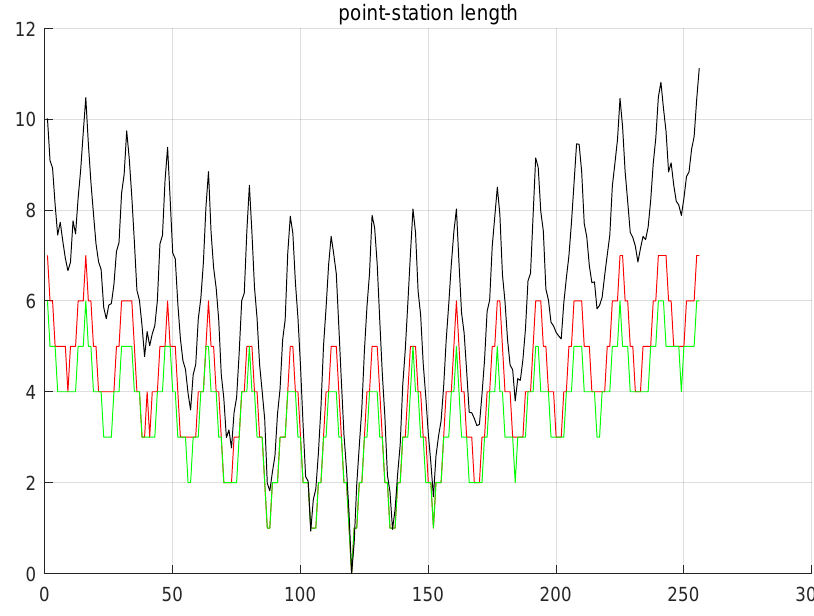
Figure 9. x -coordinate is the codes of all nodes, and the 120th node is the station. y -coordinate is the hops or distance of nodes from the station. The black curve is the distance curve from nodes to the station, the red curve is the universal node hop curve, and the green curve is the quantified distance curve from nodes to the station.